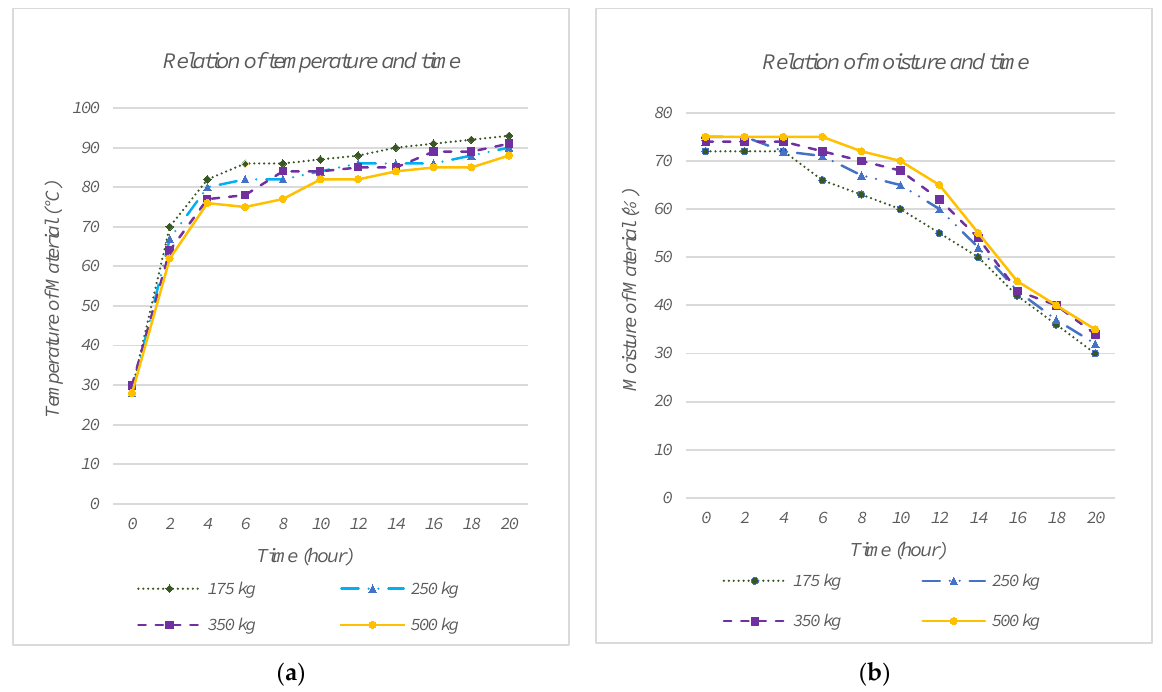
ture values obtained from the table, as shown in Figure 18.